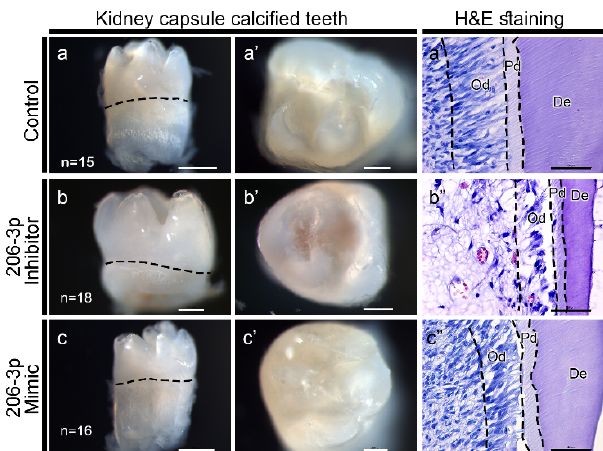
Figure 5. Renal-capsule–calcified teeth for 21 days ( a – c ). The buccal view of the teeth treated with the control ( a ), miR-206-3p inhibitor ( b ), or miR-206-3p mimic ( c ). The inhibitor-treated teeth are very small ( b ) relative to the control ( a ). Occlusal views showing the crown morphology ( a’ – c’ ). The histological sections of the calcified teeth show properly arranged odontoblast layer, predentin, and dentin in the control specimen ( a” ). The inhibitor-treated specimen showed decreased cell mass in the pulp region with a poorly di ff erentiated and developed odontoblast layer [( b” ) with thinner predentin and dentin layers ( b” )]. The mimic-treated specimen showed the proper amount of cellular mass in the dental pulp but irregularly arranged odontoblast, predentin, and dentin layers ( c” ). Scale bars 500 µ m ( a , e ), 200 µ m ( a’ , b – b’ , c’ ), 50 µ m ( a” – c”